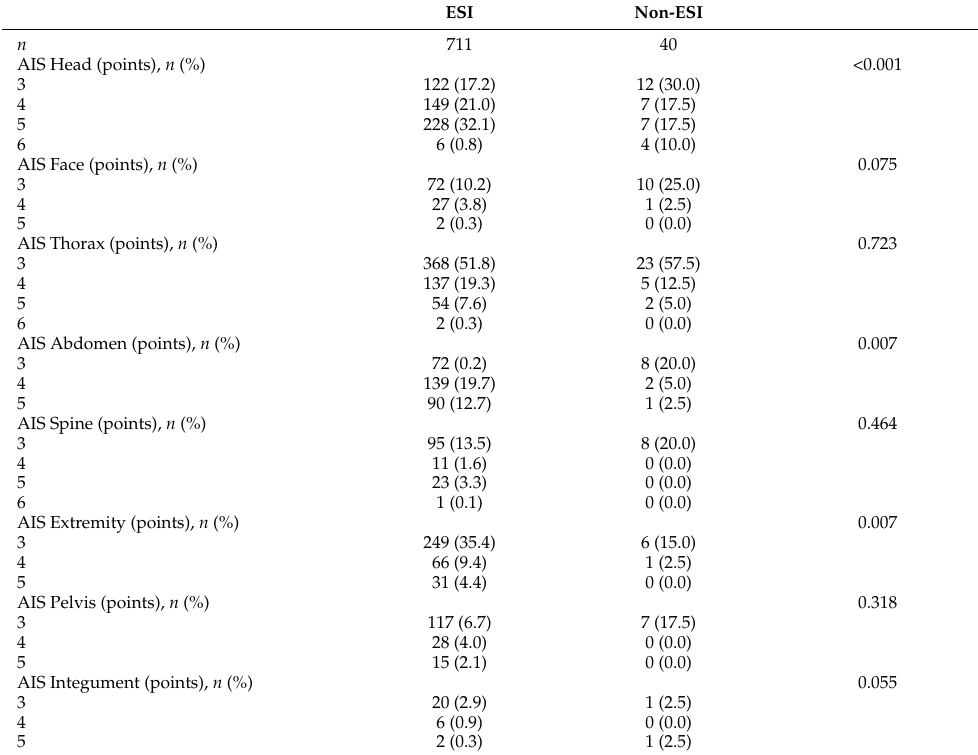
Table 2. Comparison of injury severity and injury distribution according to